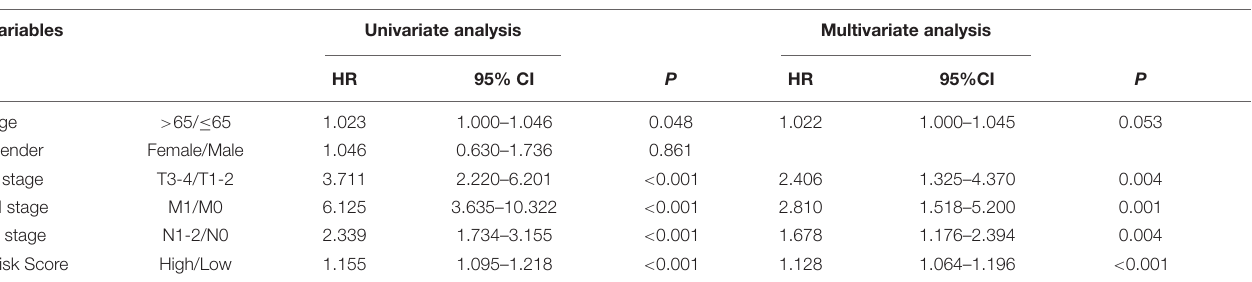
FIGURE 8 | Kaplan–Meier curves were performed for patients stratified by clinicopathological features in the TCGA set. Impact of prognostic risk on overall survival for female (A) and male patients (B) ; for patients younger than 65 years old (C) and older than 65 years old (D) ; for patients in stage I-II (E) and stage III-IV (F) ; for patients in stage T1-2 (G) and stage T3-4 (H) ; for patients in stage N0 (I) and stage N1-2 (J) ; and for patients in stage M0 (K) and stage M1 (L) . TABLE 2 | Cox regression analyses of variables with overall survival in TCGA